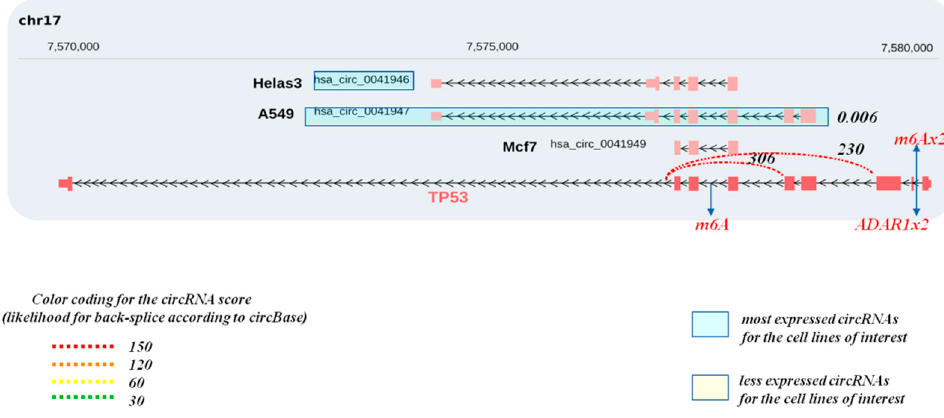
Figure 6. Potential circRNAs derived from the TP53 gene locus. Predicted circRNAs at the TP53 gene locus, based on NGS data, as deposited at circBase and CIRCpedia, are shown over the corresponding loci, based on human genome GRCh37/hg19. Cell lines in which NGS was performed to obtain the depicted circRNAs are also shown and were retrieved from circBase. The expression values for the estimated circRNAs were derived from the junction reads form of circBase and CIRCpedia from Ribo zero RNA-seq. The strength of the back-splicing event is demonstrated using a dashed line, where different scores are shown for the expressed back-spliced events. Furthermore, we indicate from miCLiP experiments [91] a consensus of m6A sites and editing sites as derived from RNA editing events using the Jacussa pipeline [92] as well as from ADAR1 CliP binding sites.